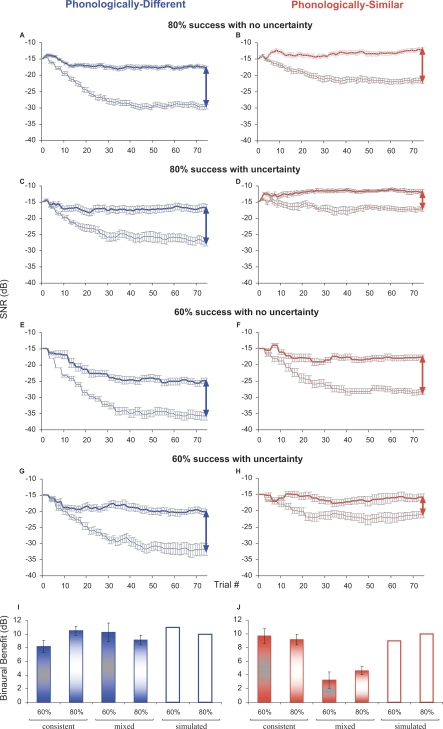
Results of Study 2, Experiments IILeft: results using phonologically different word pairs (blue). Right: results using phonologically similar pairs (red).(A–H) The dynamics of the adaptive threshold assessment for identification of word pairs as a function of trial number (averaged across subjects ± SEM, n = 15). Notations as in Figure 1. Vertical arrows denote binaural benefits.(A and B) The adaptive protocol converging to 80% correct identification with no uncertainty (i.e., using the consistent binaural protocol).(C and D) The adaptive protocol converging to 80% correct identification with uncertainty (mixed binaural protocol).(E and F) The adaptive protocol converging to 60% correct identification with no uncertainty (consistent binaural protocol).(G and H) The adaptive protocol converging to 60% correct identification with uncertainty (mixed binaural protocol).(I and J) A summary of the average binaural benefits obtained in the experiment (filled shaded bars), and the benefits calculated by an ideal listener model (open bars; see Figure S4).